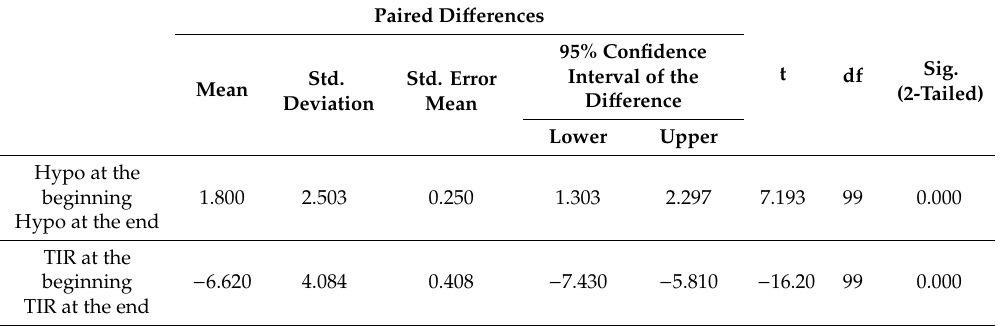
Table 2. T -test for %time spent in hypoglycemia and time in range per 24 h.